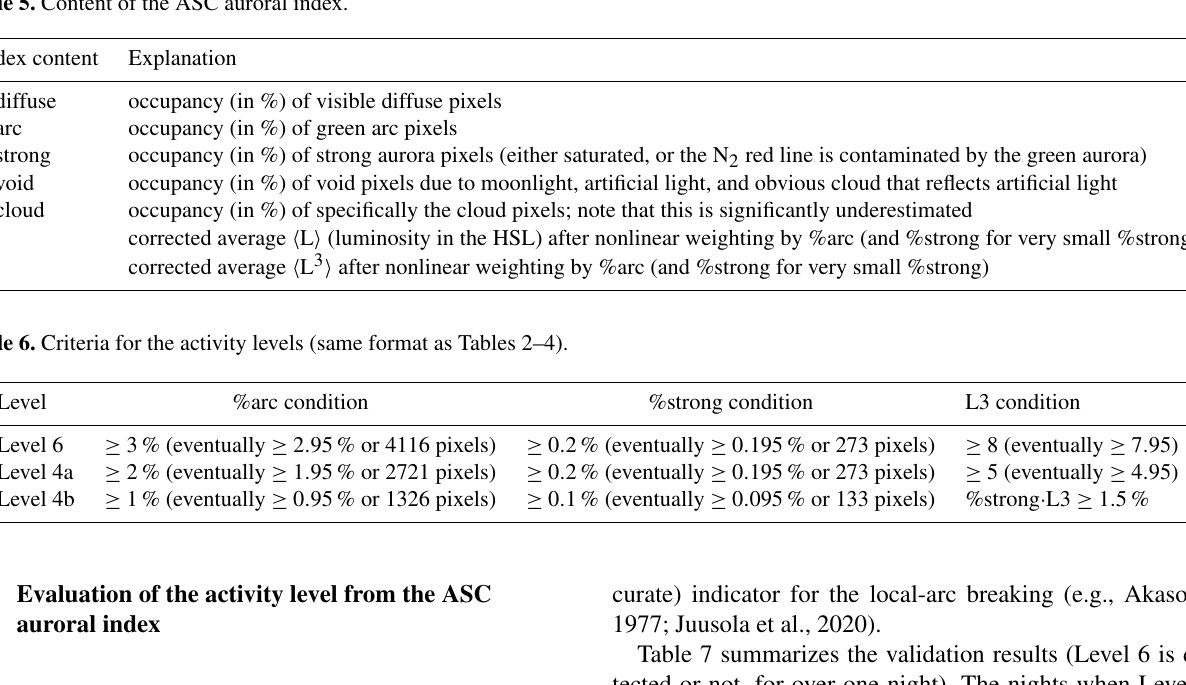
Table 5. Content of the ASC auroral index.